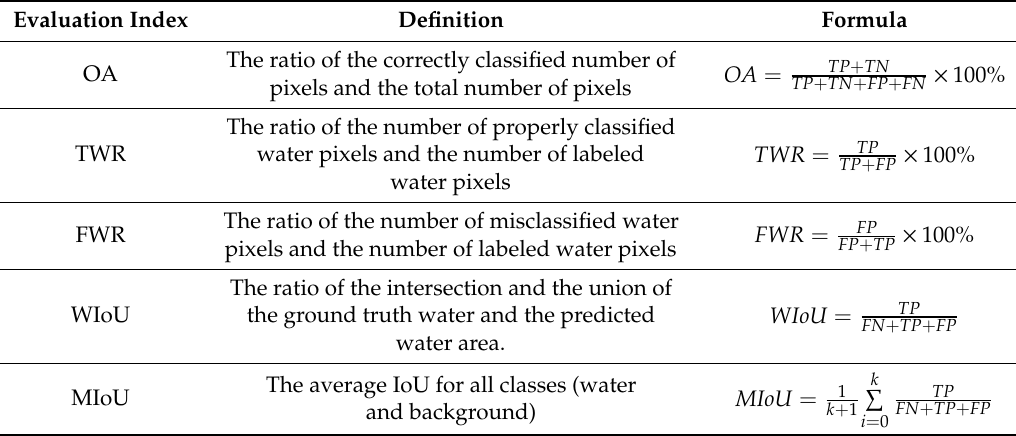
Table 2. Five evaluation metrics for the accuracy